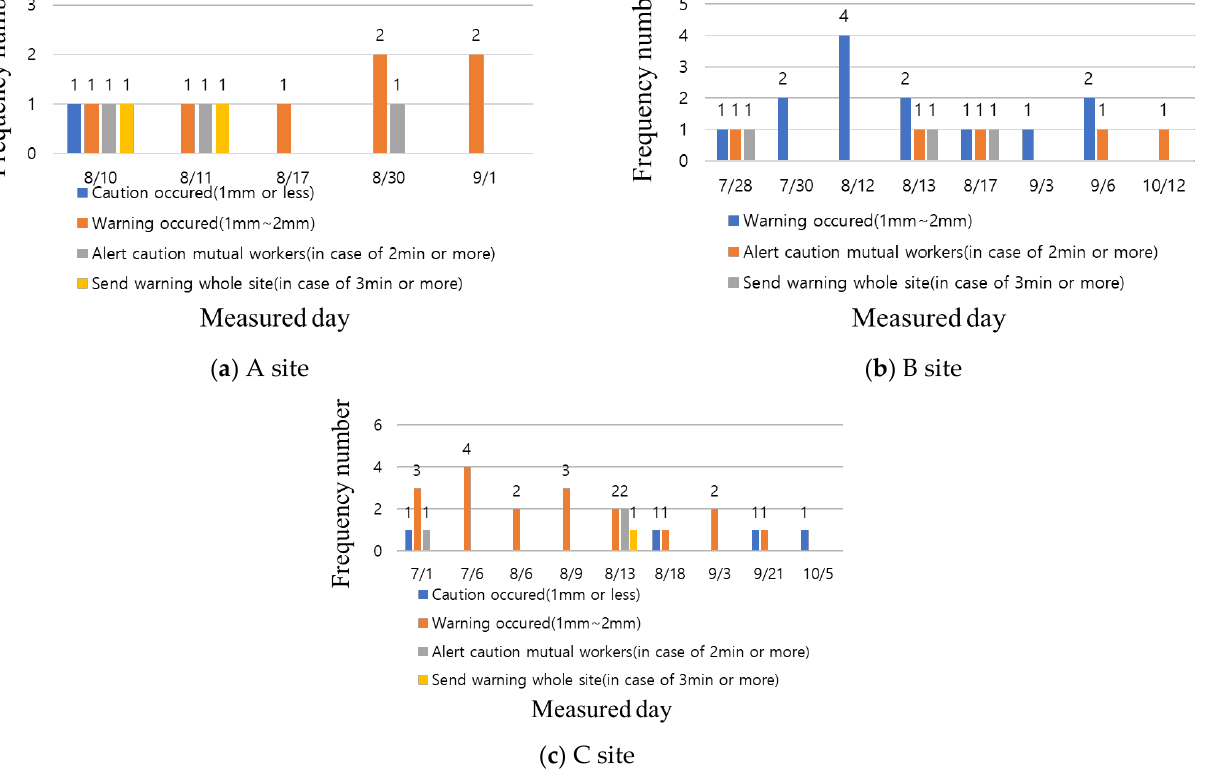
Figure 13. Analysis of structure displacement sensor data for test beds.